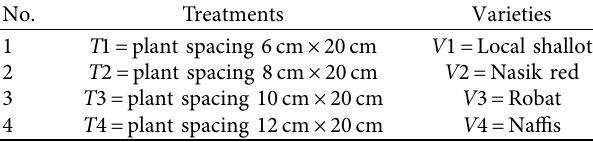
Table 1: Treatments used in the experimental feld. No. Treatments